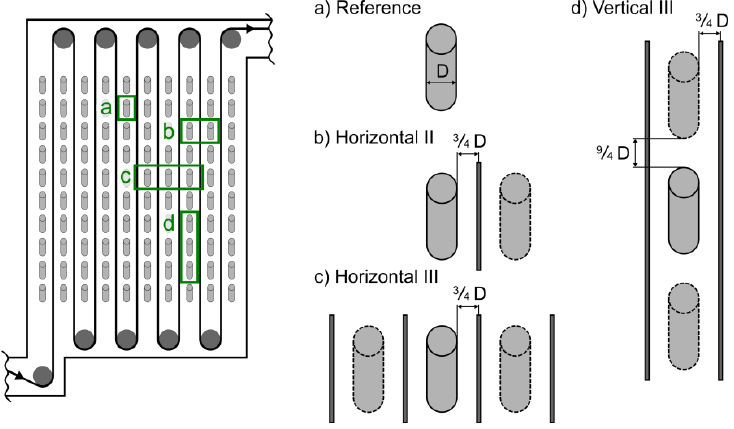
Figure 5. Heating section of a CGL and the chosen radiant tube setups.